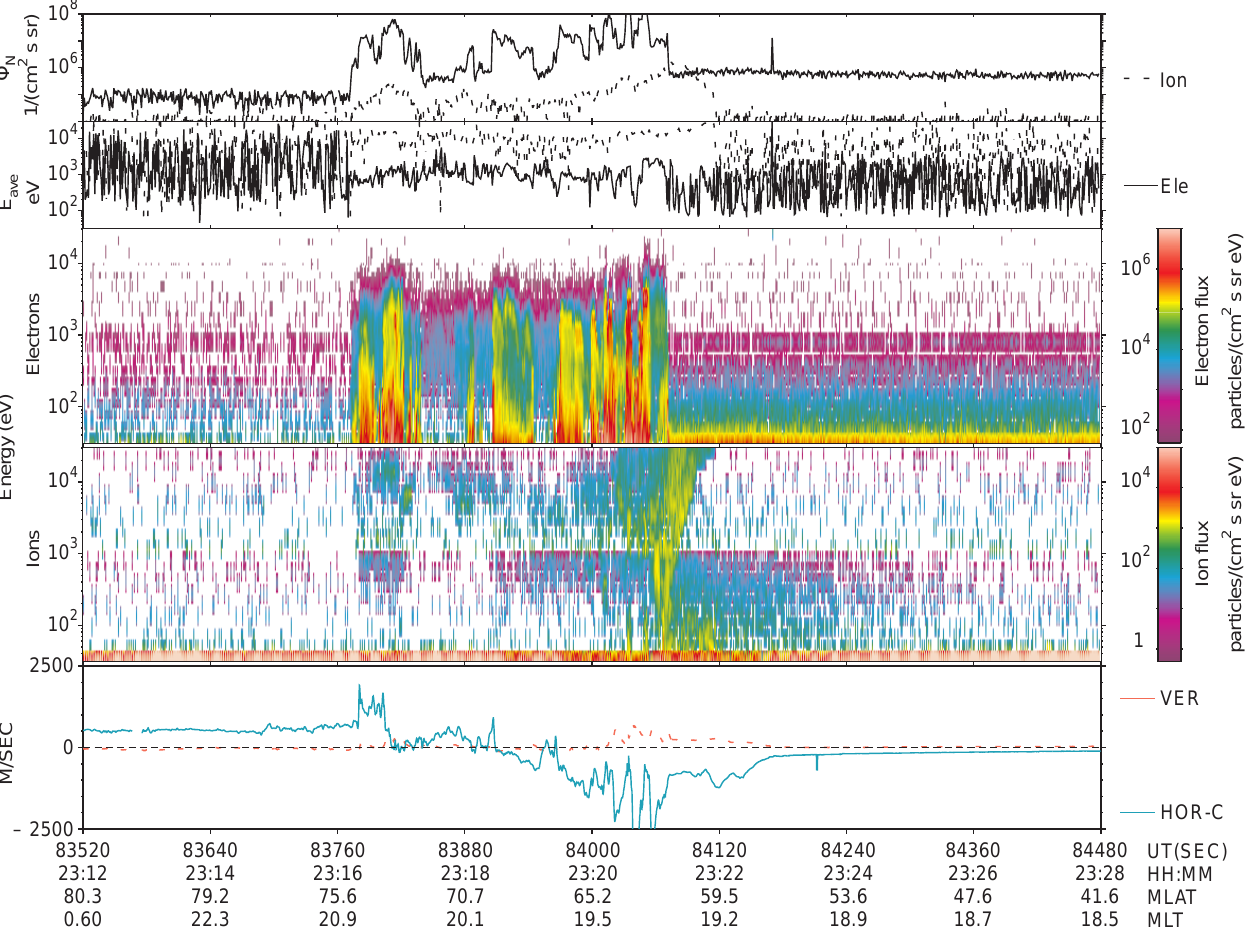
Fig. 13. Data from DMSP F8 overflight near Millstone Hill on March 21, 1990, 23:12-23:28 UT. The two upper panels show the integrated (30 eV–30 keV) electron and ion fluxes U N and their average energy E ave (cid:133) eV (cid:134) . Then the spectrogram of precipitating electrons ( 3rd panel ) and ions ( 4th panel ) are given as false-colour-coded flux values. The bottom panel gives the components of the thermal ion bulk flow